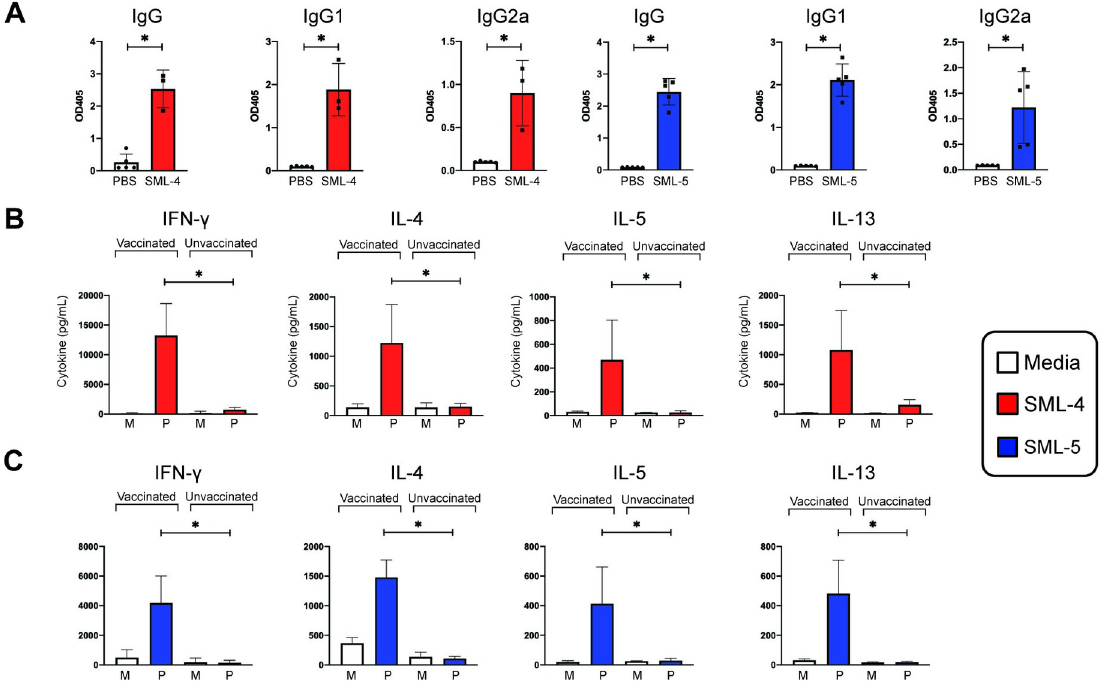
Fig 6. Parenteral vaccination with SML-4 or SML-5 in alum induces mixed Th1/Th2 cellular and humoral responses. (A) Recall responses of BALB/c mice immunized via intraperitoneal injection with SML-4 or SML-5 protein in alum adjuvant were analyzed via ELISA assays for IgG, IgG1 and IgG2a. Unvaccinated mice were given intraperitoneal injections of PBS in alum. (B and C) Supernatants from splenocytes stimulated for 72 hours with media, SML-4 (B), or SML-5 (C) were analyzed for cytokines via Luminex assays. “M” indicates stimulation with media, while “P” indicates stimulation with SML-4 or SML-5 protein. Figures are representative of two independent experiments with n = 4–5 per group.